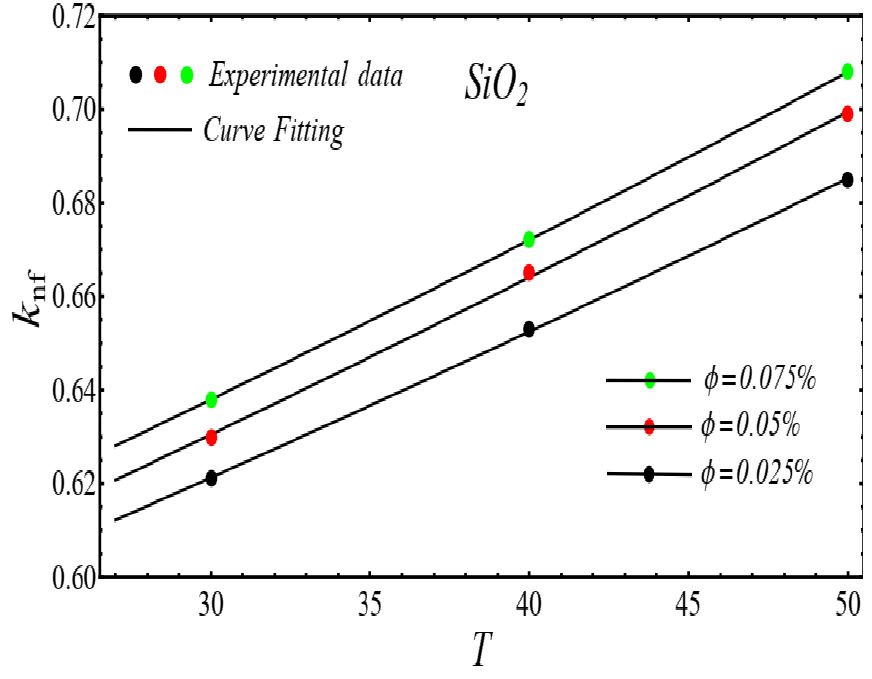
Figure 9. Fitting the Equation (4) for experimental data of SiO 2 /DIW nanofluid at different nanopar- ticle volume fractions.